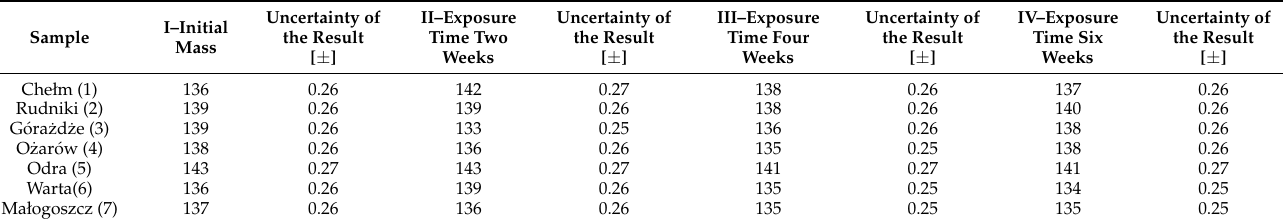
Table 4. Weight of samples made of cement pastes